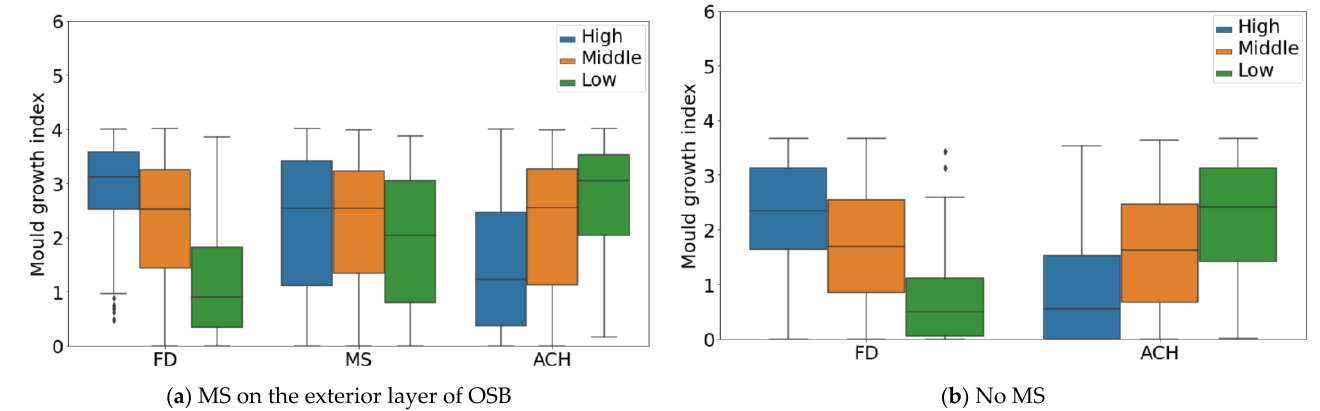
Figure 18. Boxplots of 2-year’s averaged mould growth index with scenarios of rain leakage moisture source in the future period. Note: The marks of “ ⧫ ” are outliers.